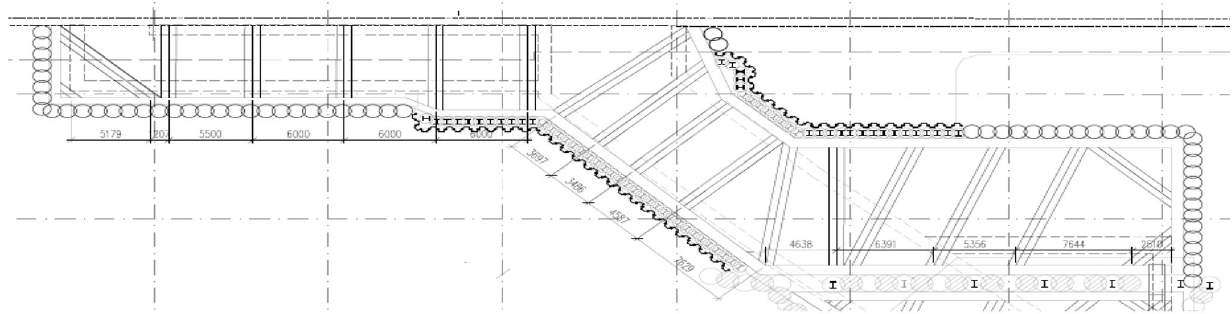
Fig. 5 Layout plan of retaining wall of zone